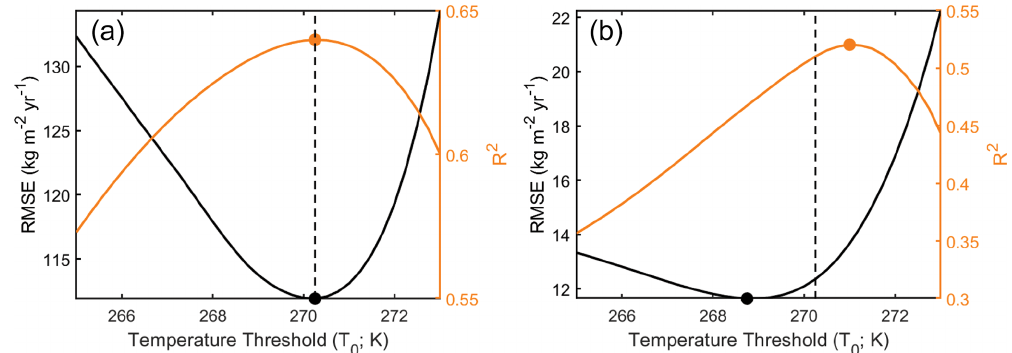
Figure 7. Degree-day model evaluation for (a) Antarctica and (b) Greenland for different temperature thresholds, T 0 . The orange and black lines represent the mean r 2 and RMSE of every grid cell for a given temperature threshold. The orange and black dots indicate the thresholds that maximize r 2 and minimize RMSE, respectively. The dashed line represents the threshold selected for each ice sheet as it maximizes the normalized distance between the two curves and yields the best model according to these evaluators. Note the differences in vertical